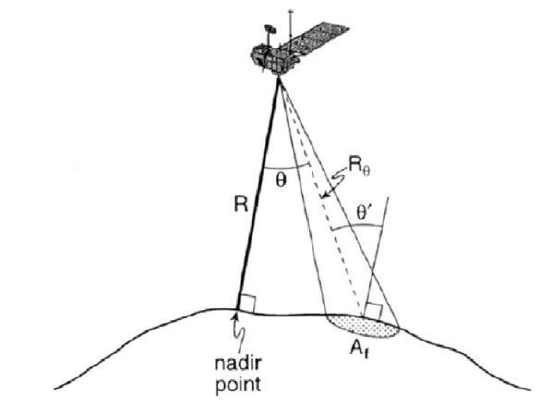
Figure 3. Altimetry